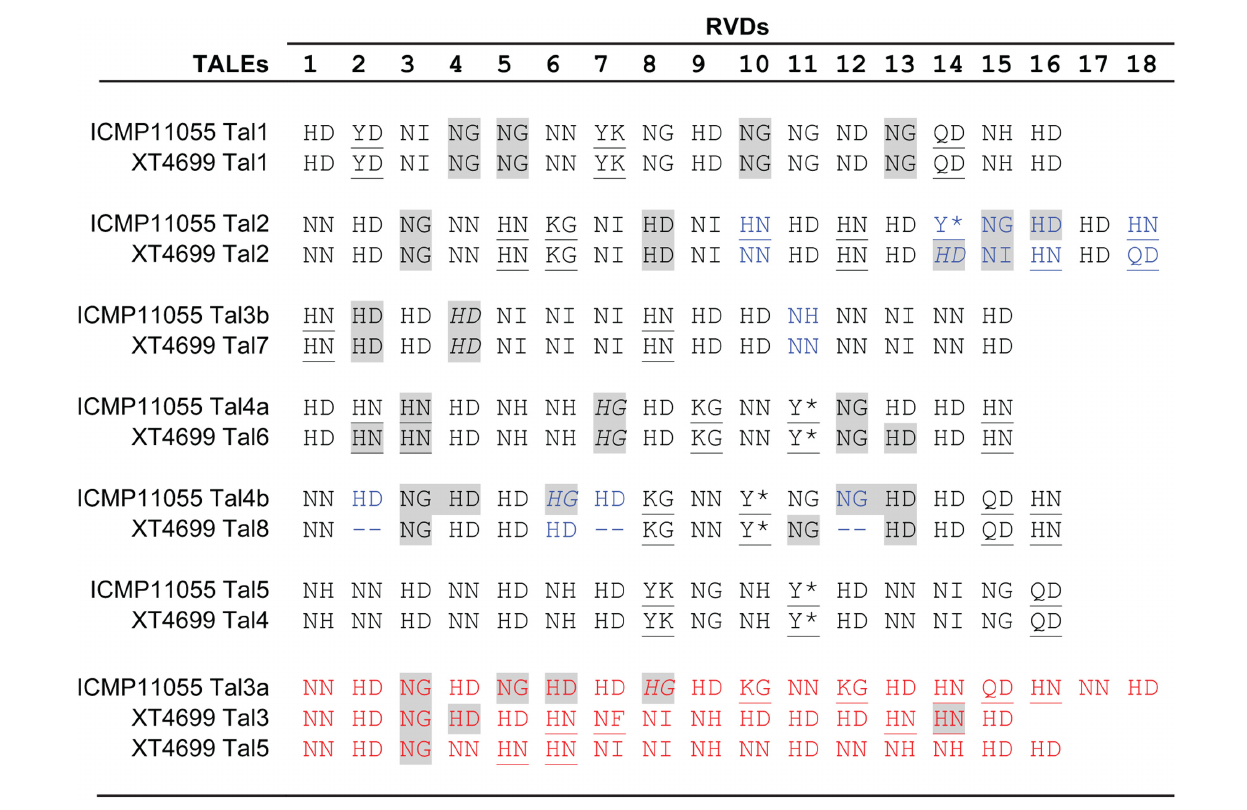
FIGURE 4 | Alignment of repeat-variable di-residues (RVDs) of TALEs of X. translucens pv. undulosa strains ICMP11055 and XT4699. RVDs that differ between otherwise highly conserved TALEs are shown in blue font. RVDs of TALEs unique to one or the other strain are shown in red font. An asterisk indicates that the second aa of the RVD is missing. Unusual RVDs discussed in the text are underlined. RVDs in a repeat of the 34 aa type, missing the fourth reside from the end relative to the 35 aa type, are highlighted in gray; RVDs in italics represent repeats of the 34 aa type that end in the sequence Q-DHG, in which the hyphen indicates the missing residue relative to the 35 aa repeat type. The other repeats of the 34 aa type end in